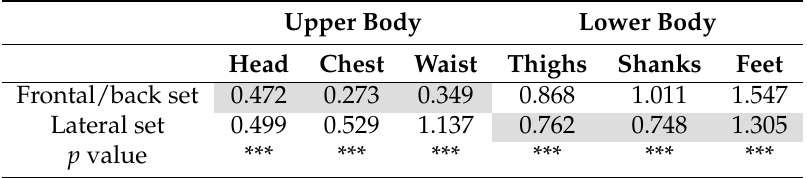
Table 10. Paired t -test on error angles in Objective 4 between the IMUs placed on different sides of body